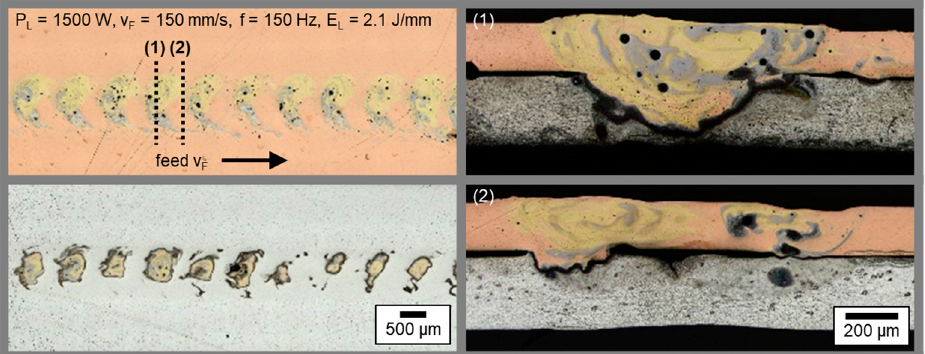
Figure 8. Micrographs (transversal sections ( left ) and cross sections from the planes of the dashed lines (1) and (2) of the transversal section top left ( right )) of Cu-Al joint welded with circular beam oscillation at P L = 1500 W, v F = 150 mm/s, f = 150 Hz.